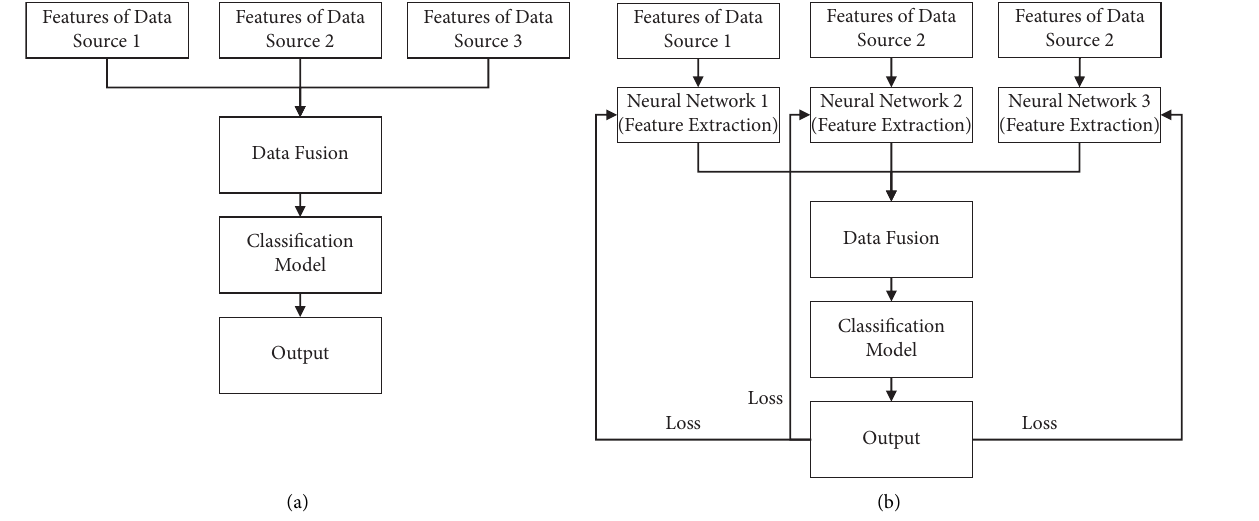
Figure 4: Early fusion and joint fusion. (a) Early fusion. (b) Joint